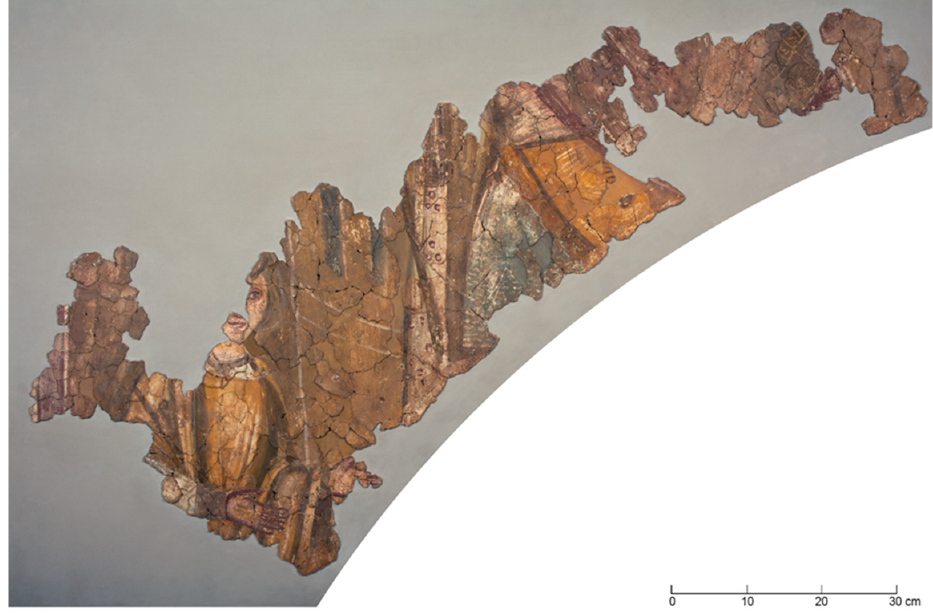
Figure 9. Painting of a female servant, late 5th to early 6th century CE. Excavated in MMS/S resi- dence, Sardis, west wall. Sardis inv. WP21.003. © Archaeological Exploration of Sardis/President and Fellows of Harvard